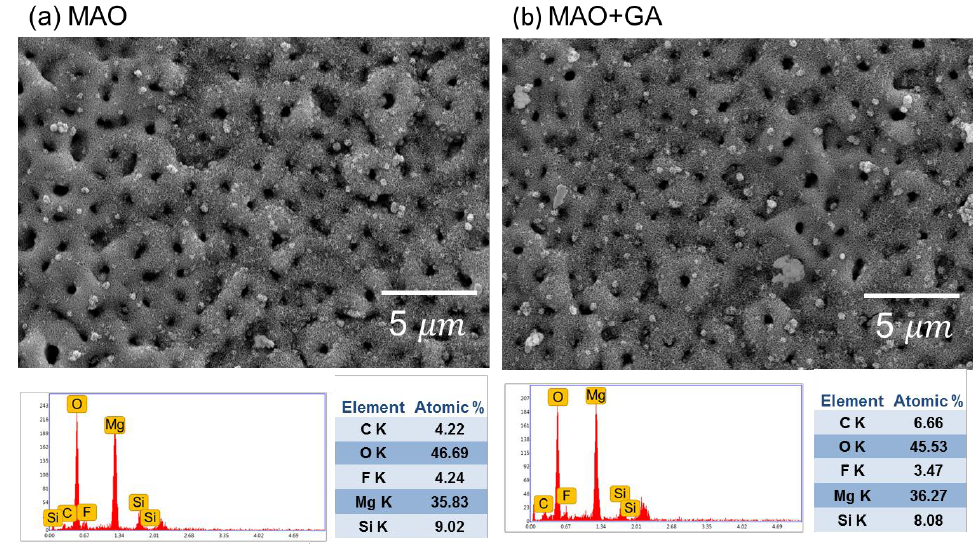
Figure 1. SEM images and EDX composition analysis of ( a ) MAO and ( b ) MAO+GA coating.